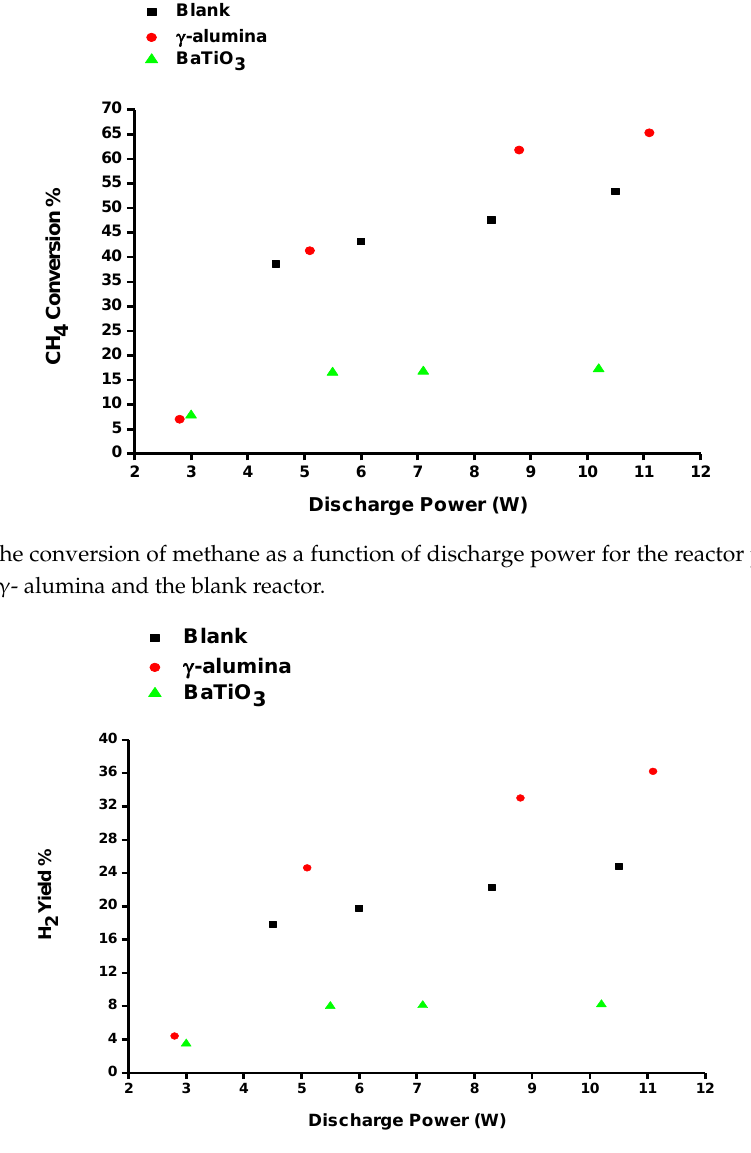
Figure 12. Yield of H 2 as a function of discharge power for the reactor packed with BaTiO 3 and γ- alumina and the blank reactor.